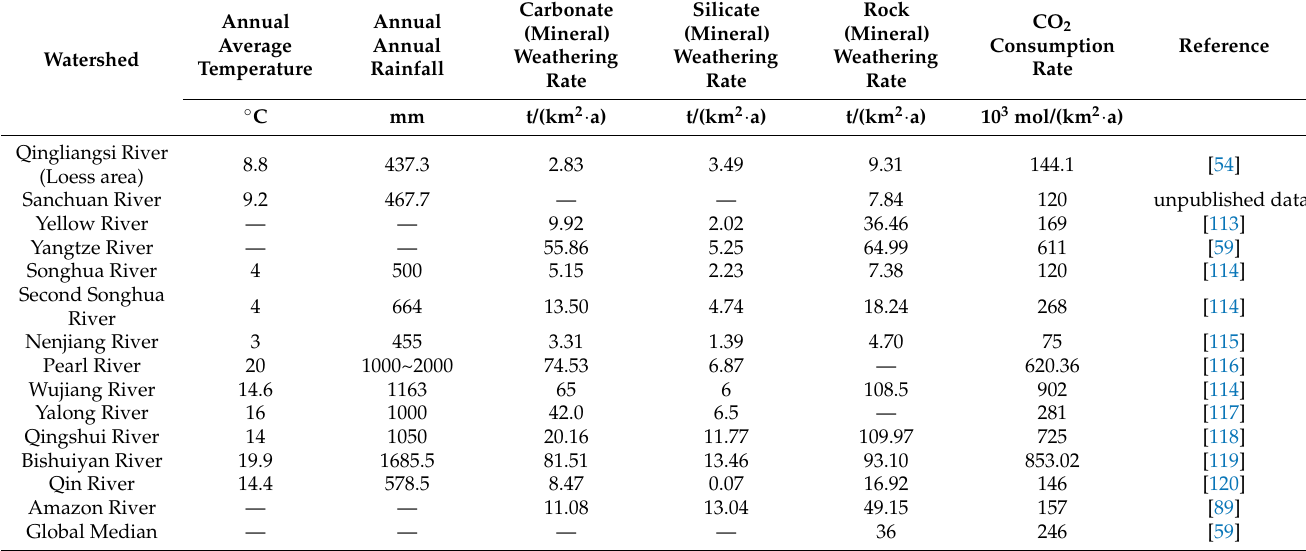
Table 2. CO 2 consumption rate and flux of mineral